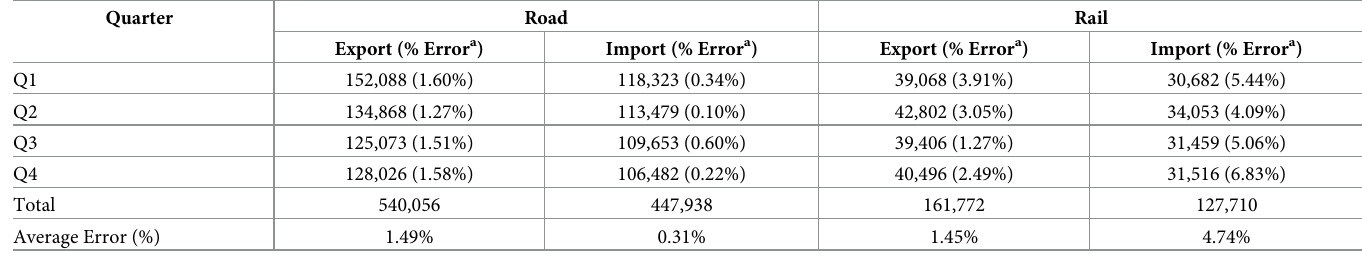
Table 5. Simulated container flows of the current LICD obtained from SIMIO (S1), together with the average margin of error in each quarter (in parentheses). Quarter